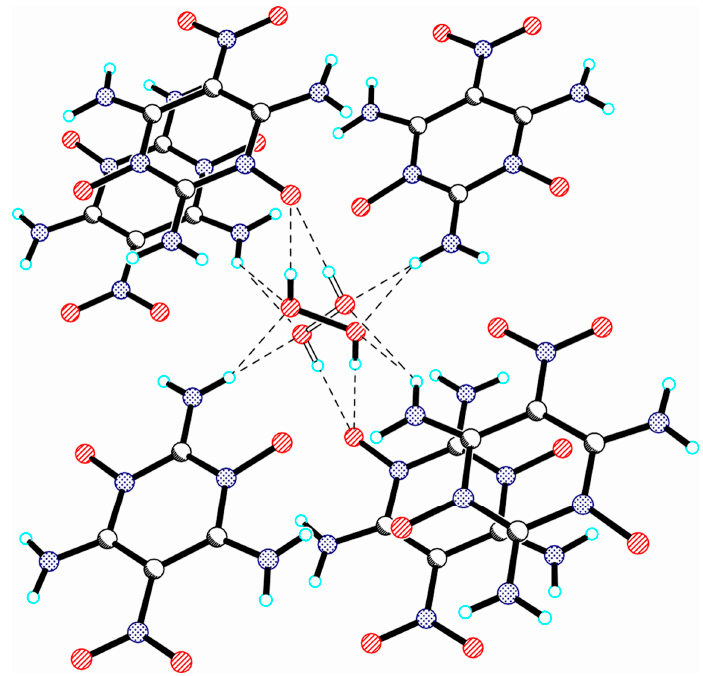
Figure 16. Fragment of the crystal structure of 2,4,6-triamino-5-nitropyrimidine-1,3-dioxide peroxosolvate, illustrating the interaction of Н 2 О 2 with surrounding host molecules through O-H···O and N-H···O bonds (dashed lines).